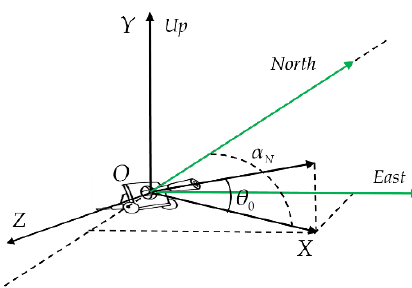
Figure 10. The launch angle and direction of the experiment.